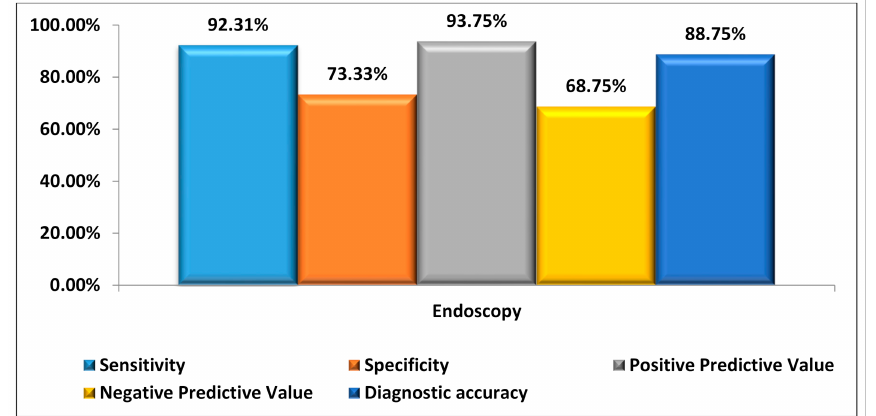
Figure 4. Sensitivity, specificity, positive predictive value, and negative predictive value of endoscopy, taking CT as the gold